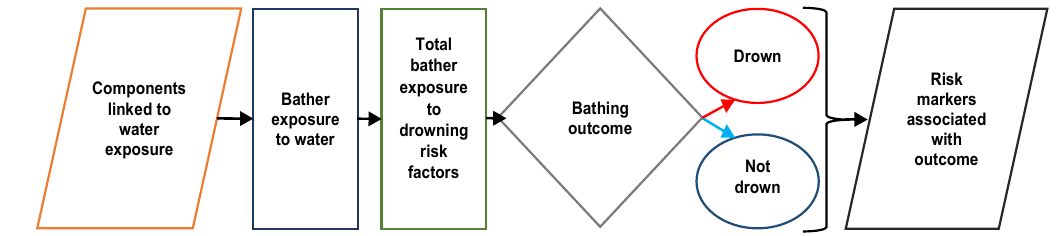
Figure 2. Flowchart depicting relationships among risk exposure, risk factors and risk markers [15]. Components may include time of day, daily temperature, day type, surf conditions or beach amenity [16]. Risk markers may include age, gender, ethnic background.